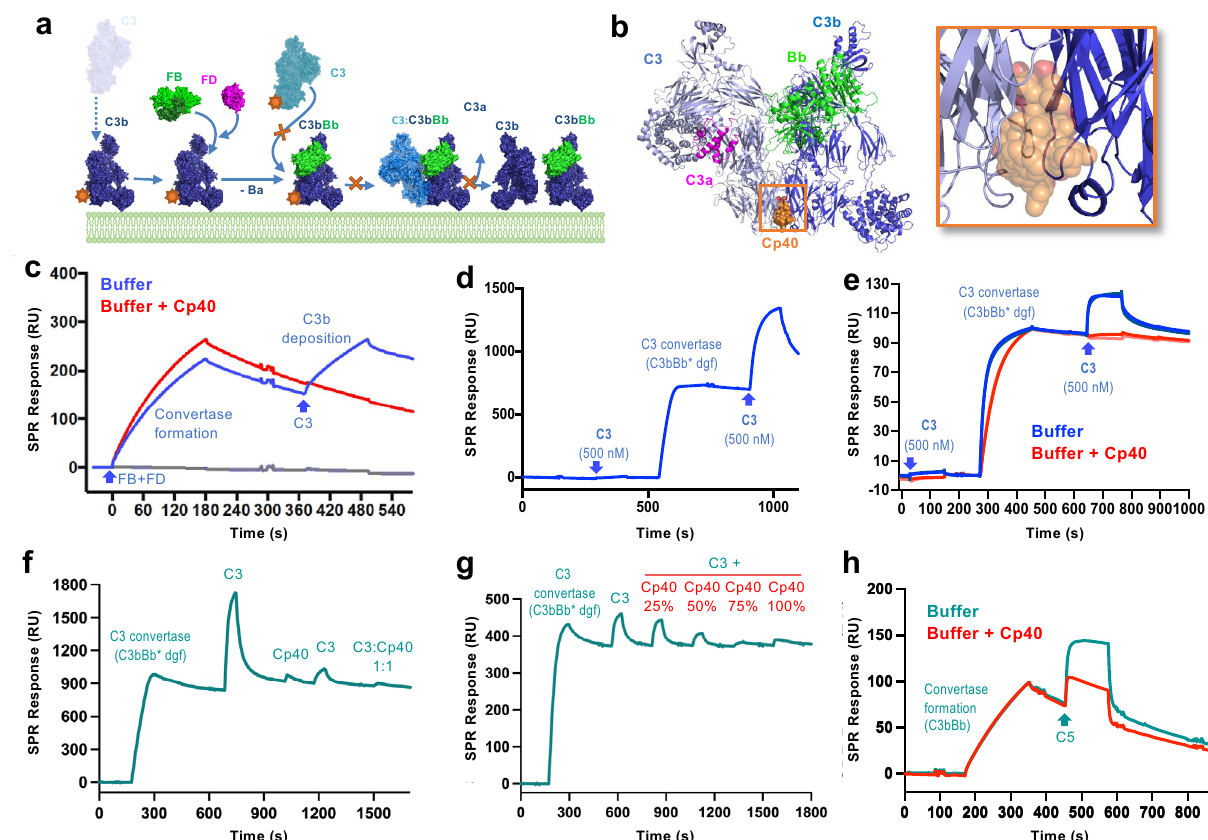
Fig. 5 | Target binding and functional mechanism of compstatin analogs. a Structure-based hypothesis of C3 activation, opsonization, and ampli fi cation usingthesamestructuresasinFig.1b.Targetbindingandinhibitionbycompstatin analogsis depictedasorangestars and crosses, respectively. b Superimposition of C3b-Cp40 and C3-Cp40 on the structure of a dimeric, stabilized C3 convertase, whichre fi nesthemodelofC3inhibitionbysuggestingthatCp40stericallyhinders the binding of C3 to C3bBb. c SPR analysis of the in fl uence of Cp40 on convertase formation and activity. The presence of Cp40 (red) does not inhibit formation or decay of C3bBb, but prevents subsequent C3b deposition upon C3 injection in absence of the inhibitor (blue), similar to the complete absence of a convertase (grey). d Selectivity of soluble C3 for C3bBb (formed in a stabilized, inactive